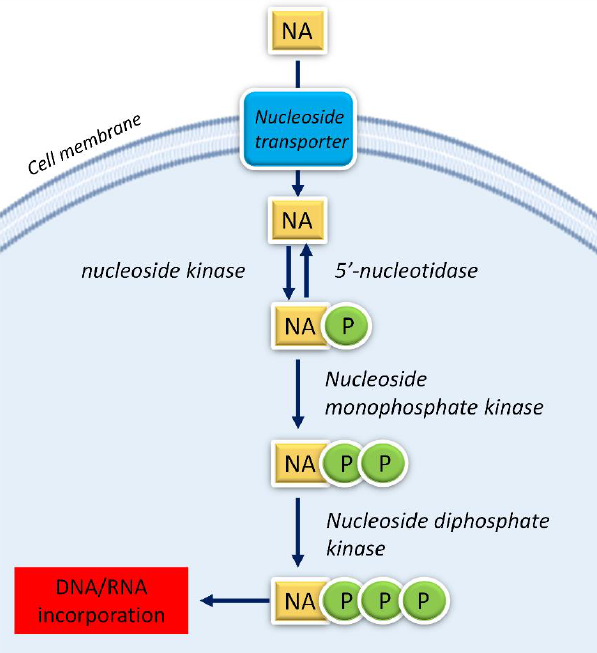
teristics concur in determining a generally better tolerance profile when the NAs are used as antiviral drugs rather than as antitumors.